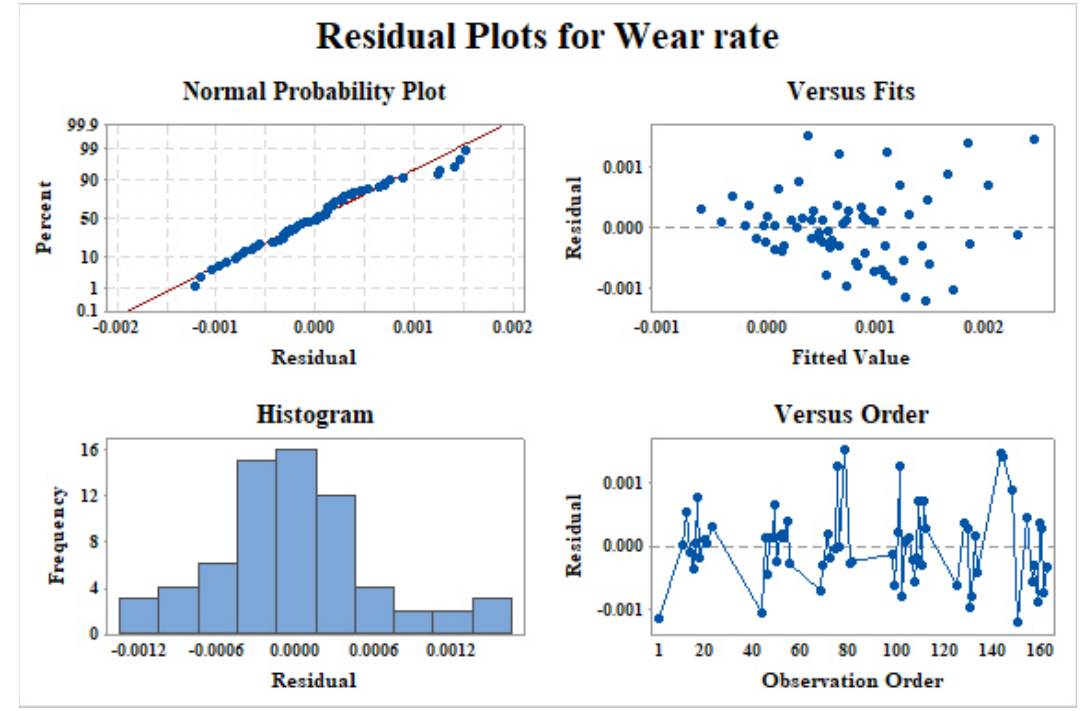
Figure 11. Residual plots for wear rate.